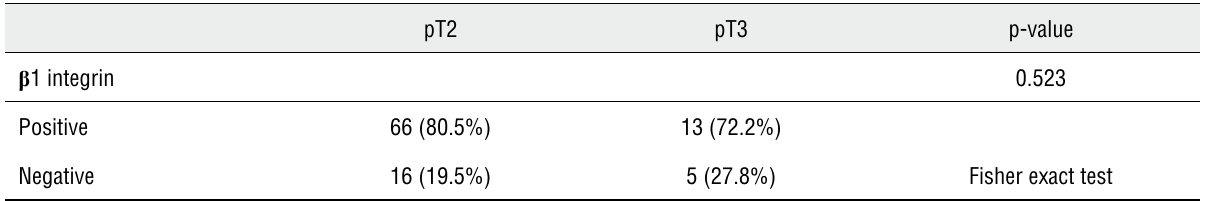
Table 3 - β 1 integrin expression according to pathological